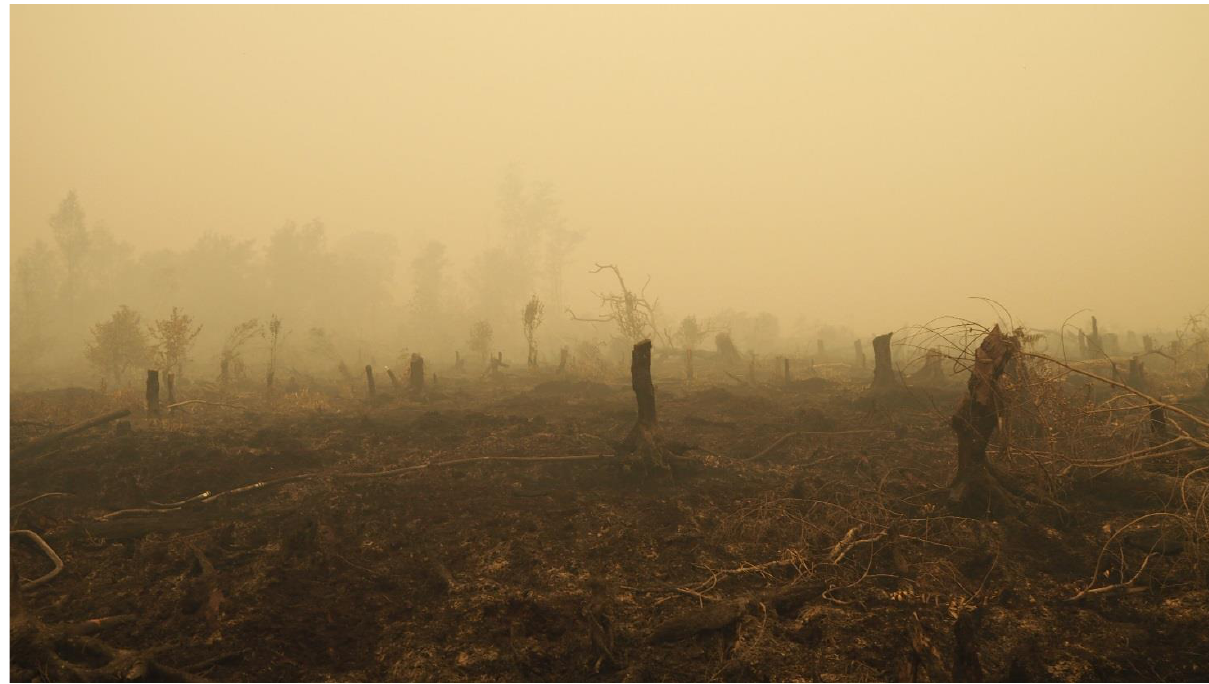
Figure 4. Burned peatland shrouded in haze during the major 2015 fire season in southern Borneo. Some standing forest is still visible in the background. Note the fire-fighters’ hose pipe running across the middle of the picture. Photo: Suzanne Turnock /